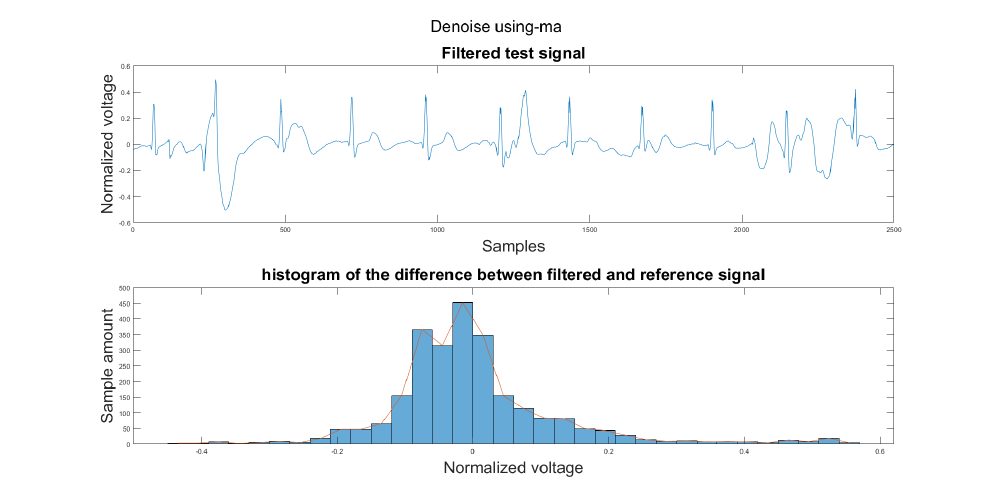
Figure A38. (1) Test signal, (2) histogram of the